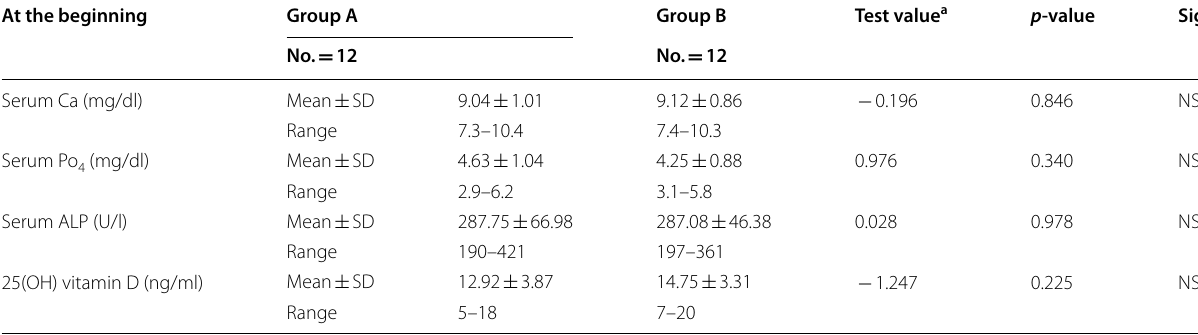
Table 6 Comparison between group A and group B regarding metabolic profile and vitamin D before vitamin D supplementation